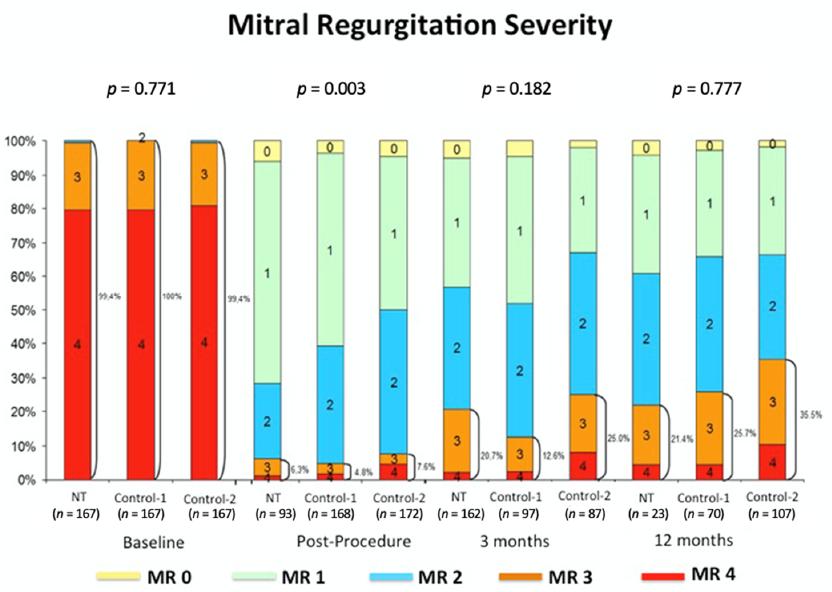
Figure 3. MR severity at